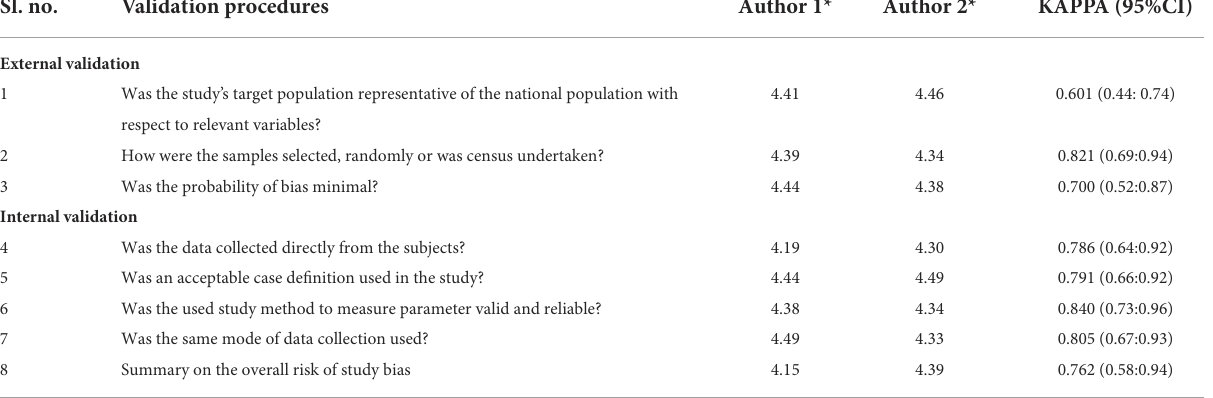
TABLE 1 Interrater agreement testing between two raters in using the risk of bias tool. Sl.